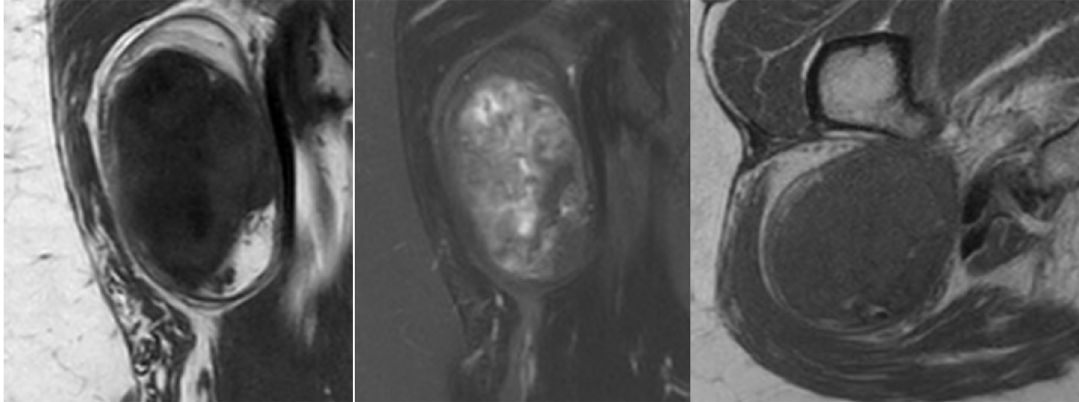
Figure 2. From left to right; front t1 and t2-weighted MRI sequences and axial t1 MRI sequence of the right hip.